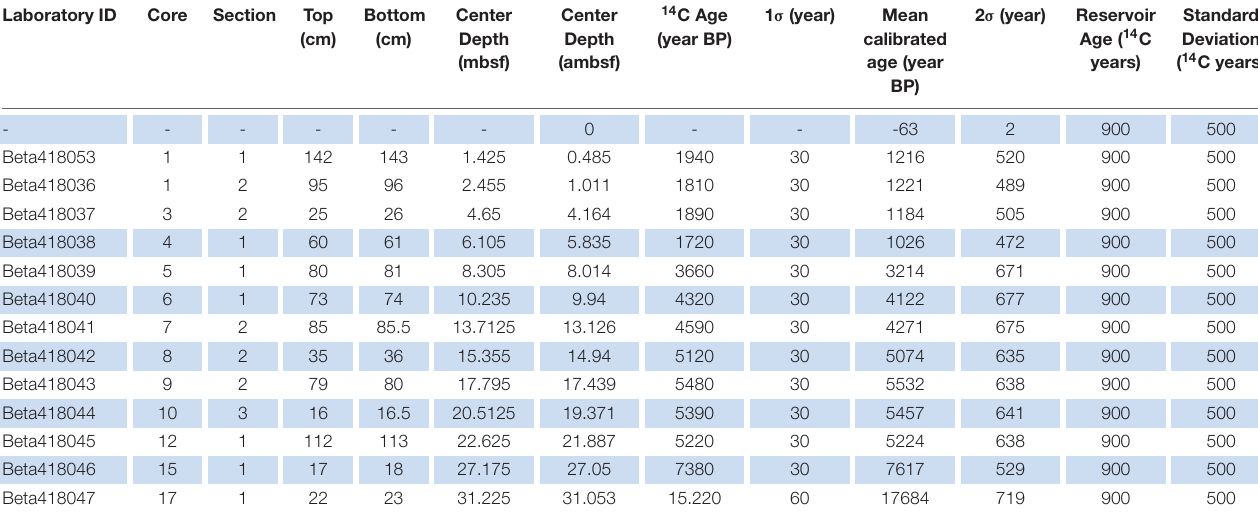
Note: The samples in shaded rows have been included for age-depth